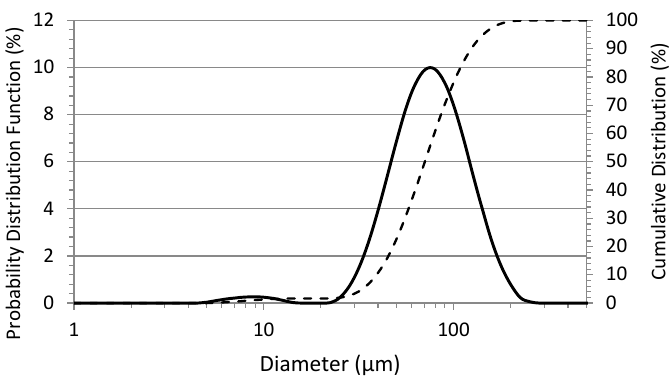
Figure 2. Particle size distribution, relative (solid curve) and cumulative (dashed curve).